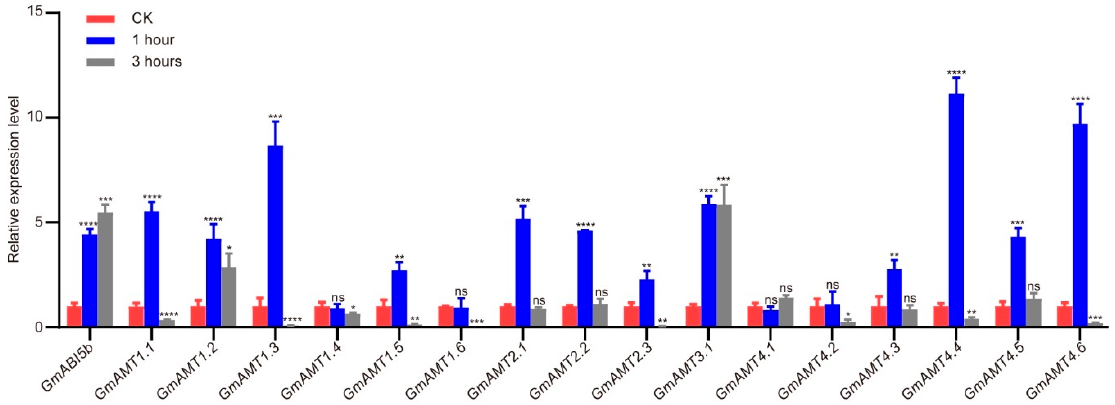
Figure 10. Gene expression analysis of GmAMTs in response to exogenous ABA treatment. RT-qPCR was used to analyze the expression of GmAMTs in roots treated with 50 µM ABA for 1 and 3 h. GmABI5b was used as a positive control. GmELF1b was used as a reference gene. The data were analyzed using student’s t -test for statistically signi fi cant di ff erences (*, p < 0.05; **, p < 0.01; ***, p < 0.001; ****, p < 0.0001; ns, no signi fi cance).